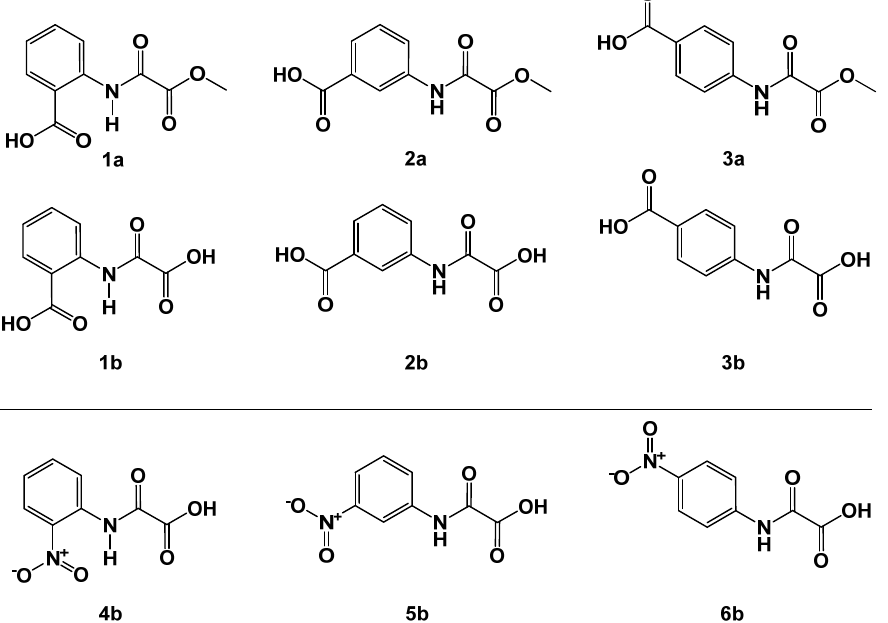
Figure 4. Oxalamic acids methyl esters 1a – 3a and corresponding acids 1b – 3b ( upper panel ); o-, m- and p -nitro-substituted N -phenyl-oxalamic acids 4b – 6b ( lower panel ). Table 1. Carboxy substituted N -aryl oxalamic acid derivatives 1a – 3b . Nitro-substituted N -aryl oxalamic acids 4b – 6b . Data fit with GRAPHPAD PRISM 5. Standard error of the fit given in µ